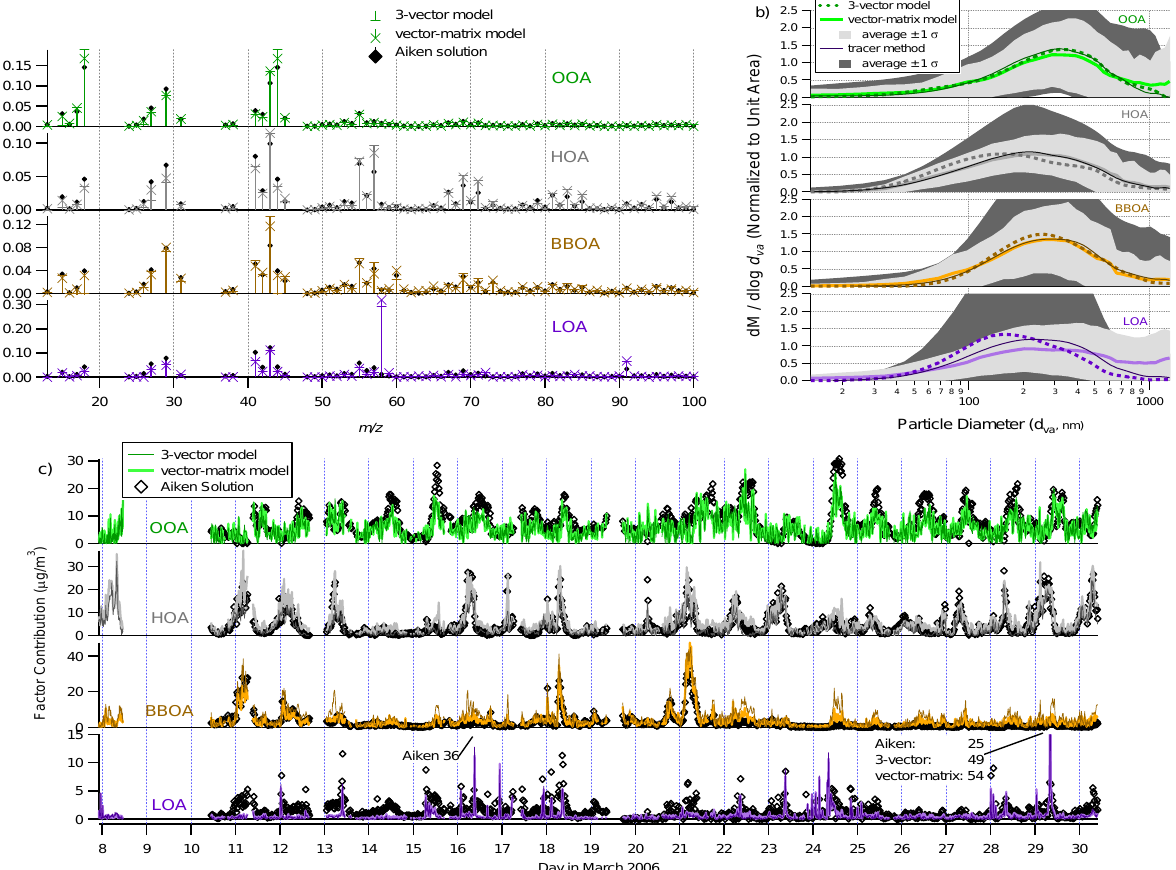
Fig. 10. Comparison of the factors from the best solutions of the 3-vector and vector-matrix models and the HR-MS solution for (a) mass spectra, (b) average size distributions, and (c) time series. The grey shaded region in (b) denotes ± 1 standard deviation of the variation in time of the size distribution in the vector-matrix model. Standard deviations for the family of 3-vector solutions are less than 2% and are not